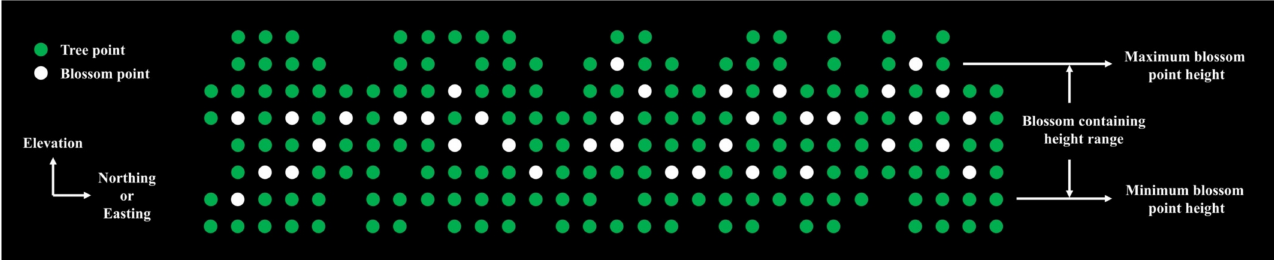
Figure A8. Schematic diagram showing the calculation of blossom containing height range of a downsampled tree row point cloud from a side